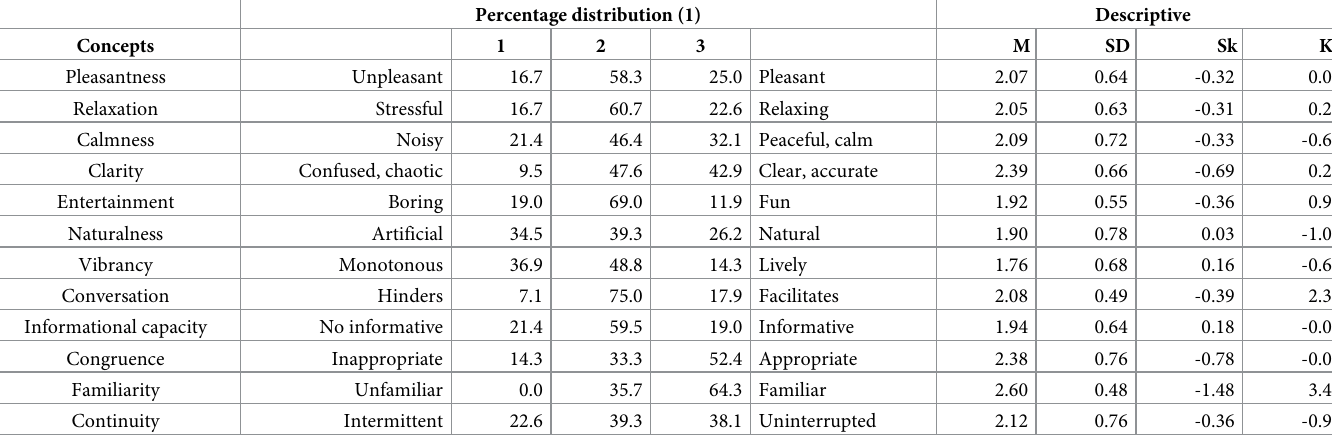
Table 3. Descriptive data of the scale version with three measurement attributes ( SSC-3A ) (polychoric matrices; n =